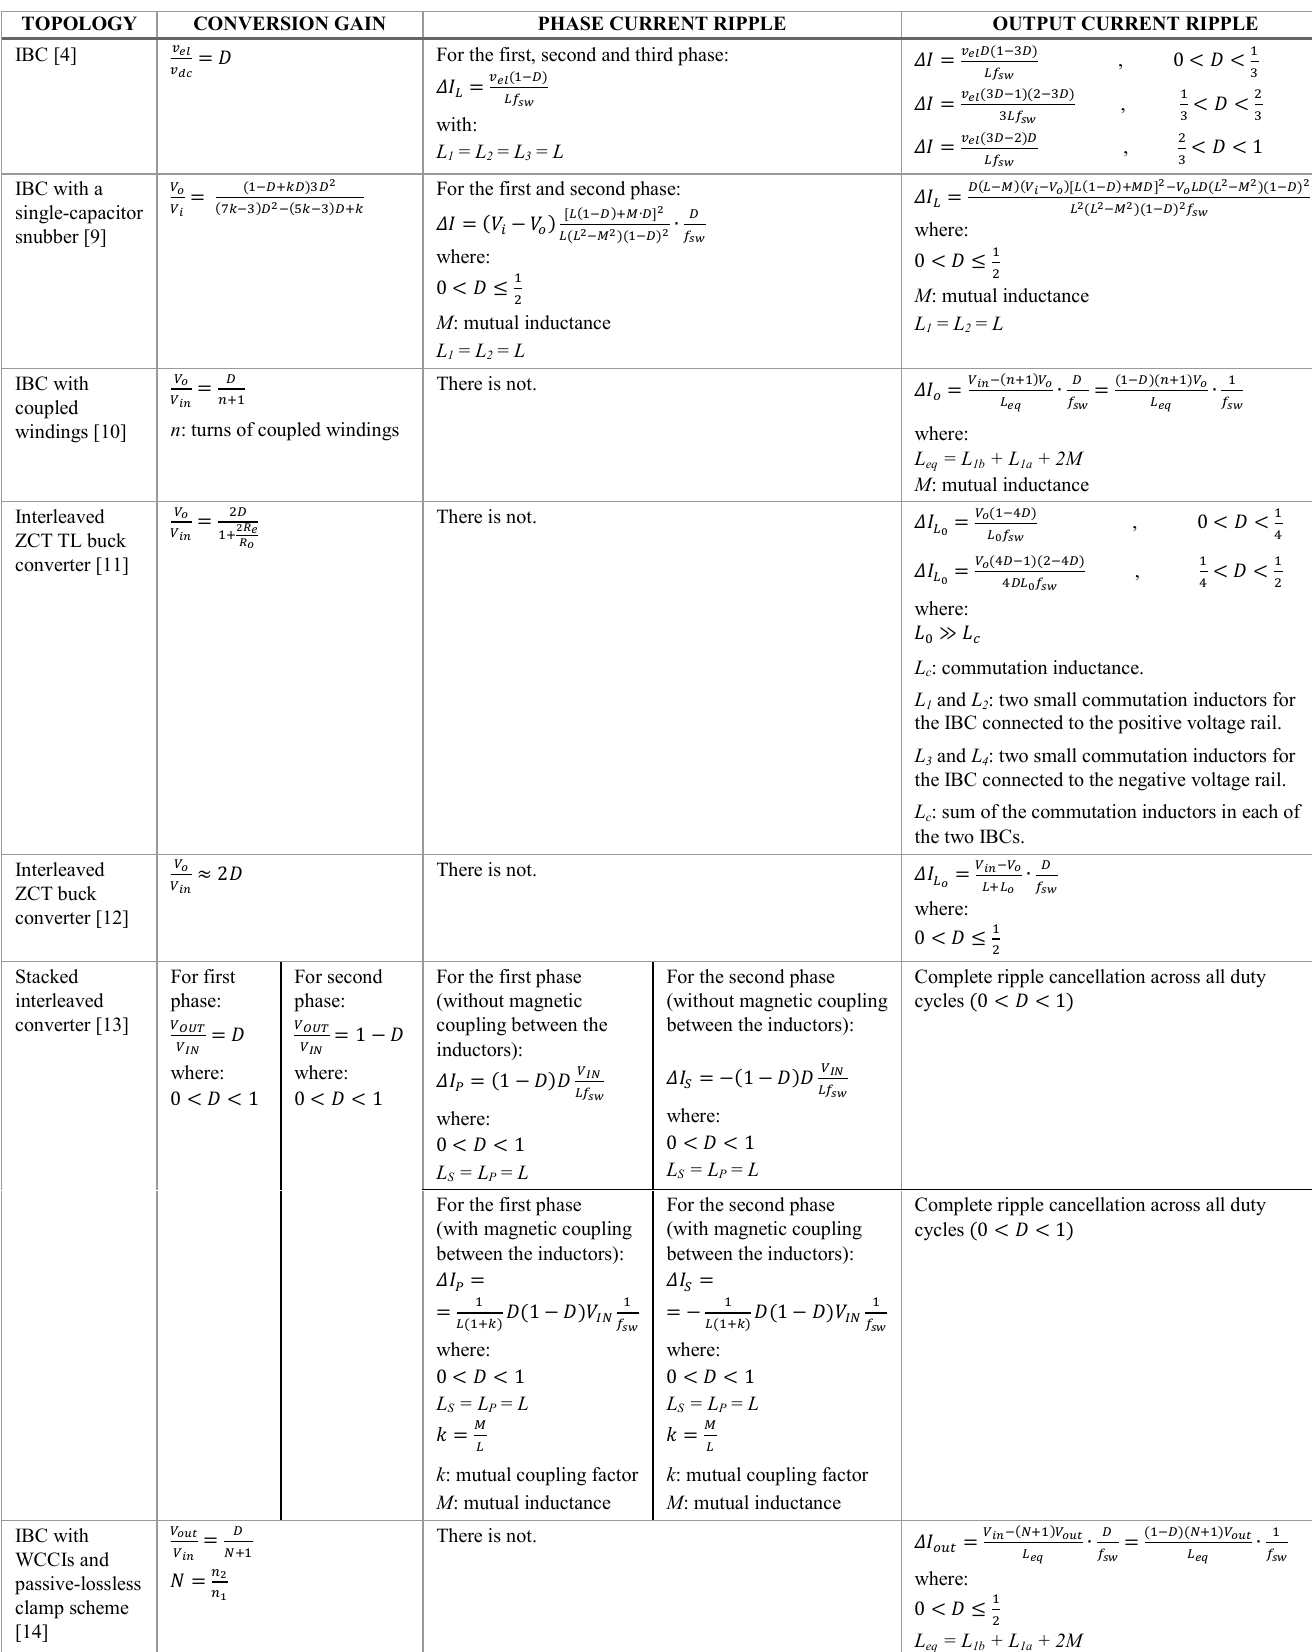
C OMPARISON OF INTERLEAVED STEP - DOWN CONVERTERS FROM CONVERSION GAIN AND CURRENT RIPPLE POINT OF VIEW